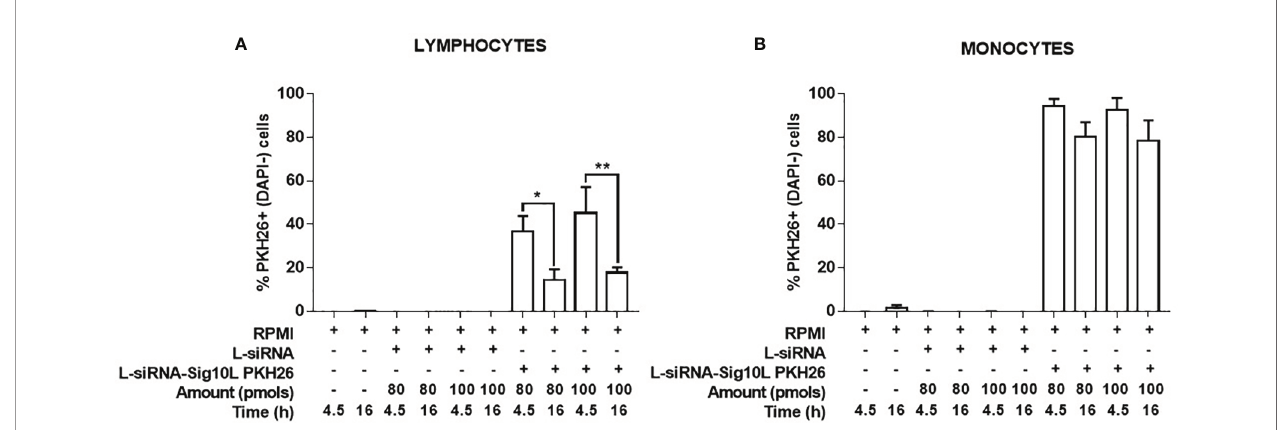
FIGURE 3 | Evaluation of PKH26-labeled LiposiRNA-Sig10L internalization in HD PBMC. Flow cytometry analysis of HD PBMC treated for 4.5 h or O/N with indicated doses of unlabeled LiposiRNA (L-siRNA) or PKH26-labeled LiposiRNA-Sig10L. Histograms show the total percentages PKH26 + (DAPI − ) lymphocytes (A) and monocytes (B) upon the indicated treatments performed for 4.5 h and O/N. Gating strategy is illustrated in Figure S2 . Data are expressed as mean ± SEM of n = 3 HD samples. *p < 0.05, **p < 0.01.